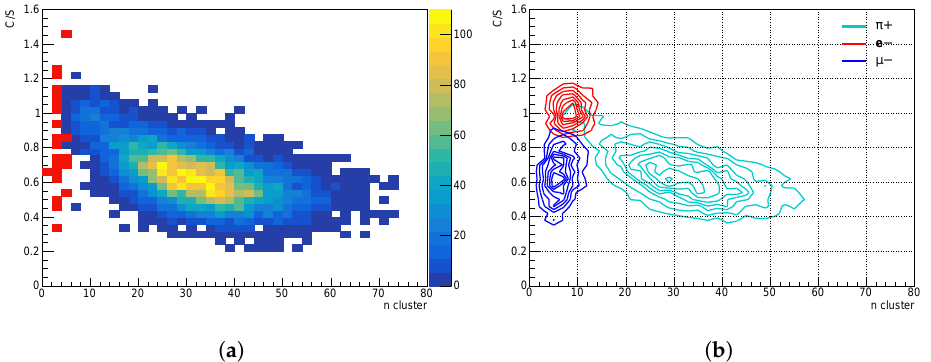
Figure 8. The number of clusters vs C/S for ( a ) 20 GeV pions (palette) overlain by the ones with the dual-readout corrected energy less than 5 GeV (red), ( b ) 20 GeV pions (cyan), electrons (red), and muons